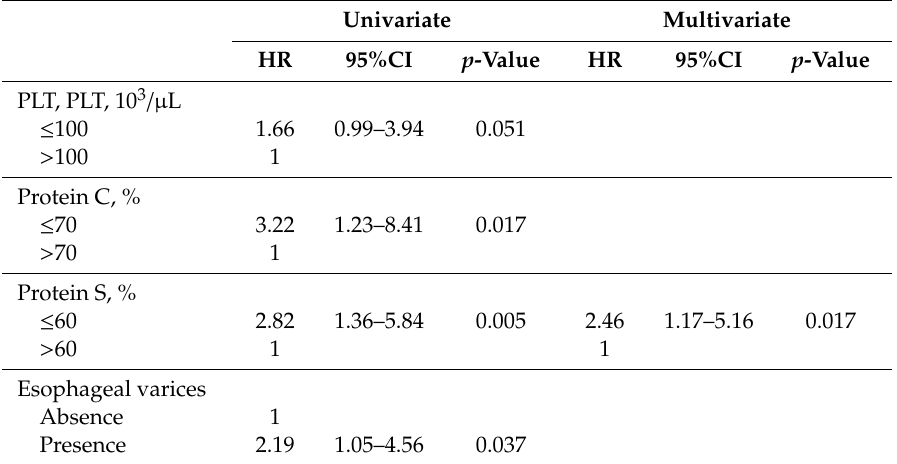
Table 2. Univariate and multivariate analyses of cirrhotic patients by logistic regression on PVT. Univariate Multivariate HR